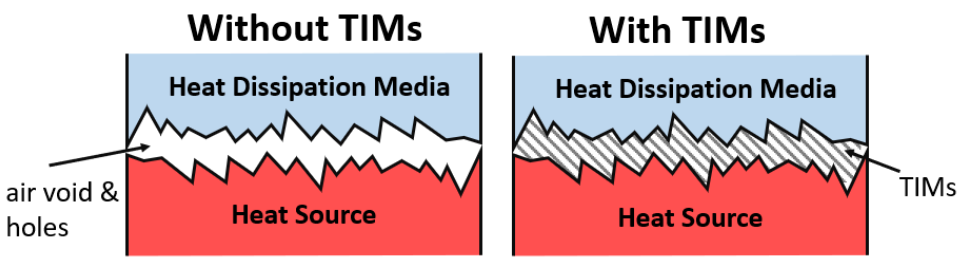
Figure 6. Schematics of thermal interface materials.